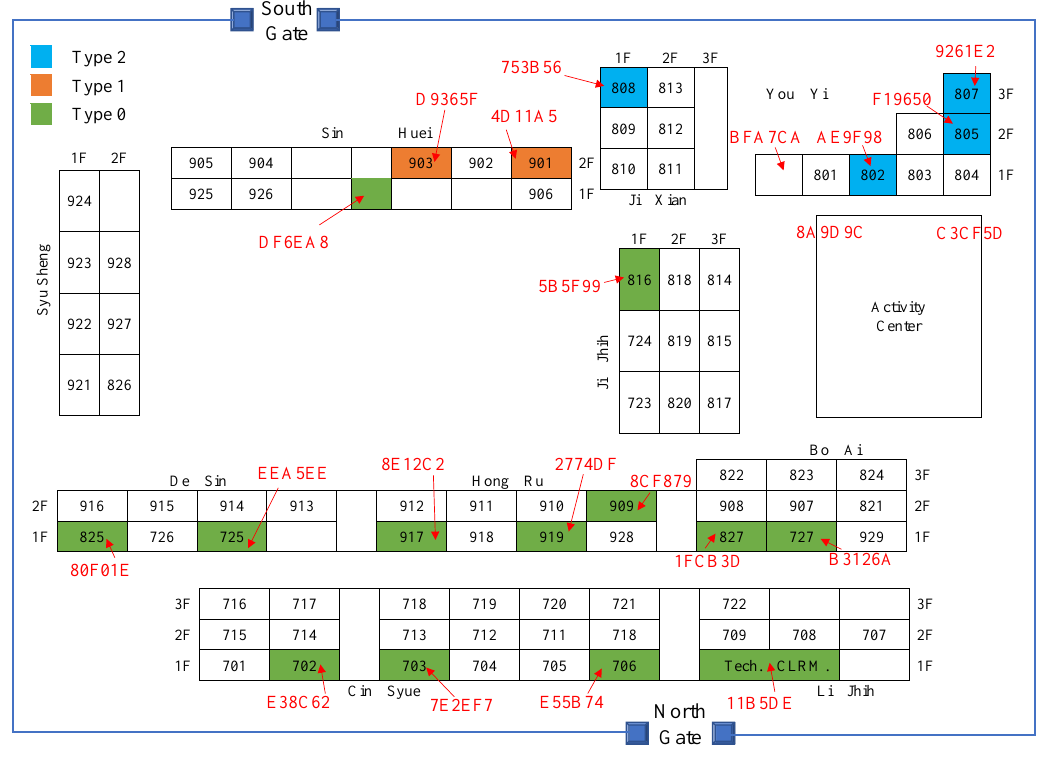
Figure 28. School